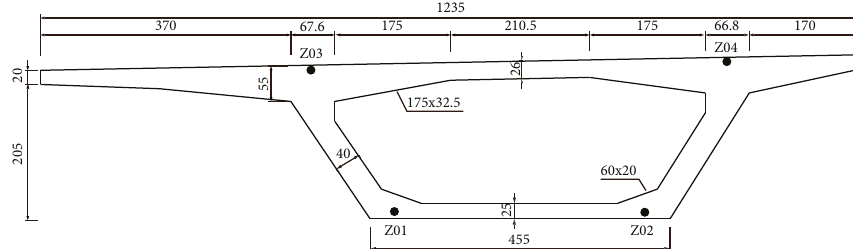
Figure 17: Stress measuring points arrangement of the mid-span section (cm).